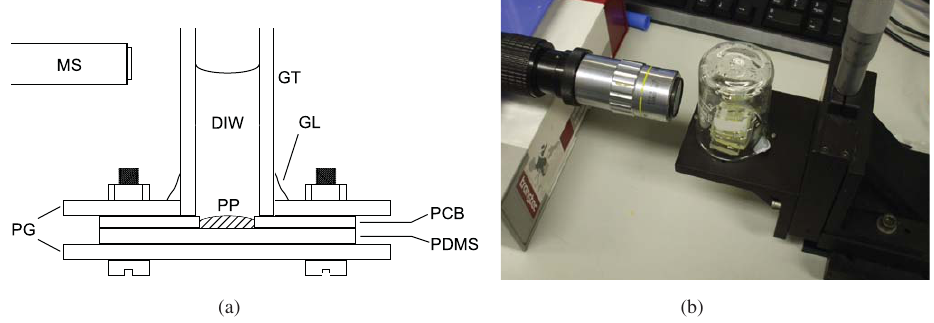
Fig. 2. Experimental setup for plasmodium force measurement: (a) A schematic illustration of plamodial force measurement setup. MS: Microscope, GT: Glass tube, DIW: Distilled water, GL: Glue, PP: Physarum plasmodium, PG: Plexi glass, PCB: Printed circuit board, PDMS: Polydimethylsiloxane silicon rubber. (b) A photo of the